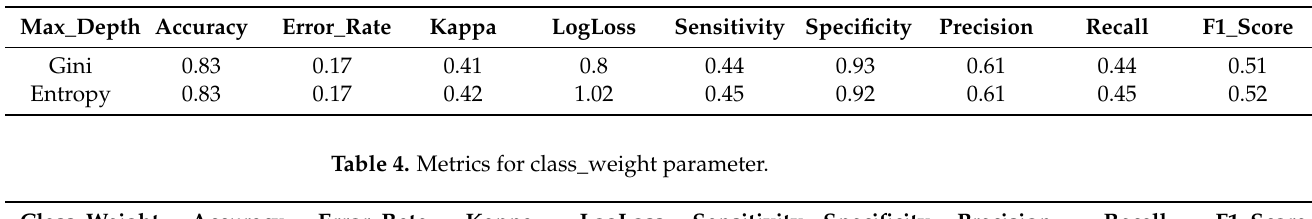
Table 3. Metrics for max_depth parameter.